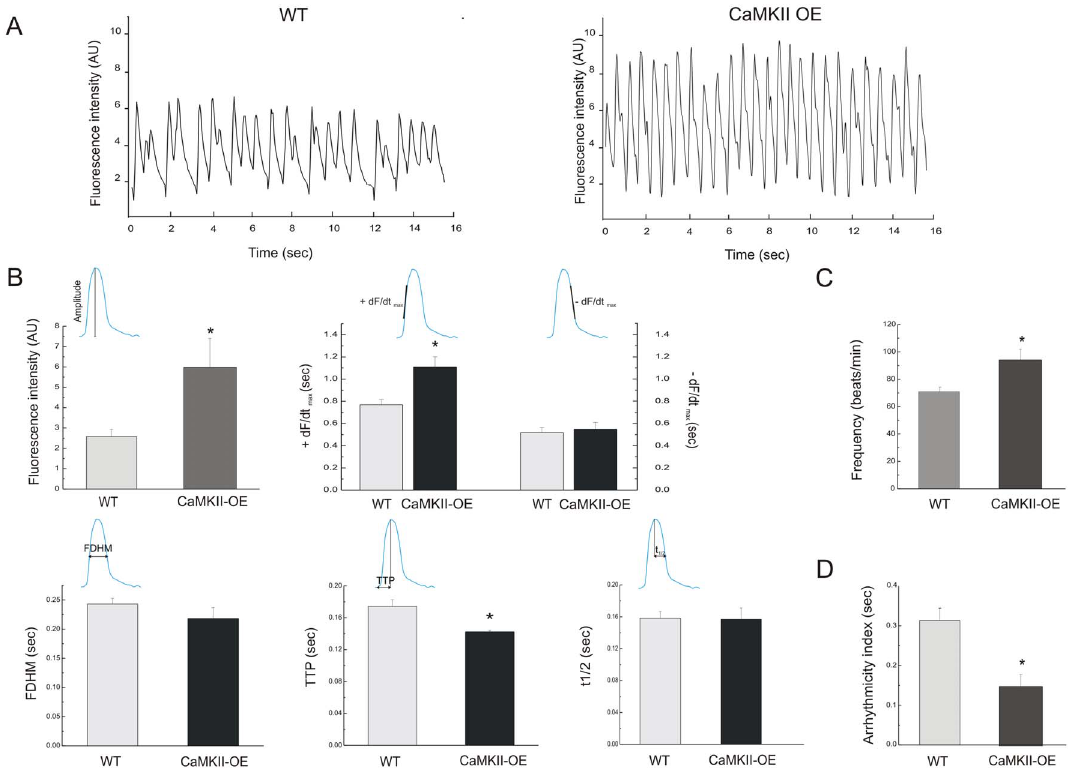
Figure 7. Overexpression of CaMKII increases heart rate, reduces arrhythmogenesis and improves Ca 2 + dynamics. A: Typical records of control flies and heterozygous flies that contain one extra copy of CaMKII (CaMKII-OE). Flies that overexpress the kinase exhibited increased spontaneous frequency and fluorescence amplitude compared with control flies. B: Summary data showed changes in transient Ca 2 + dynamics, like the rise of fluorescence amplitude (top, left graph) and the maximal rate of rise of fluorescence + dF/dt max without changes in 2 dF/dt max (top, right graph). FDHM was not changed with CaMKII overexpression (bottom, left graph) and TTP was shortened (bottom, middle graph) without changes of t 1/2 (bottom, right graph). An increment of spontaneous frequency (C) and reduction of arrhythmicity index (D) was observed in CaMKII-OE flies. Mean 6 SEM of 28 flies. *p # 0.05.